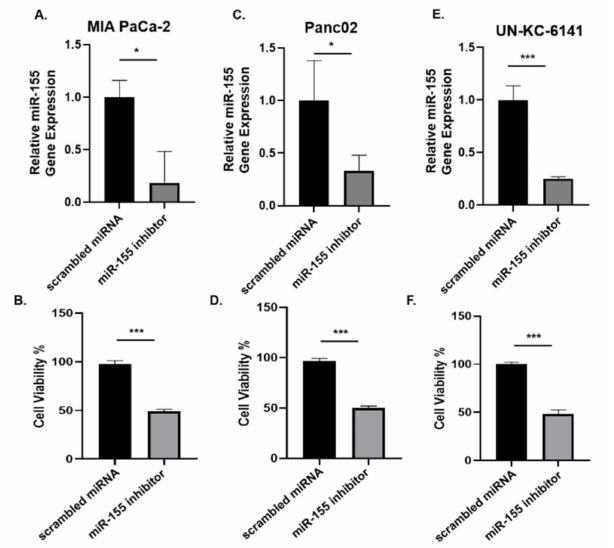
Figure 2. Inhibition of miR-155 expression decreased the viability of PC cells in vitro. The indicated human and mouse PC cells were treated with miR-155 inhibitor or scrambled miRNA (100 nM) for 24 h and assessed for ( A , C , E ) miR-155 gene expression by qPCR or ( B , D , F ) cell viability by MTT assay. Data presented as the mean ± S.D. of each experimental group ( n = 3). * p < 0.05; *** p < 0.001 (by two-tailed t